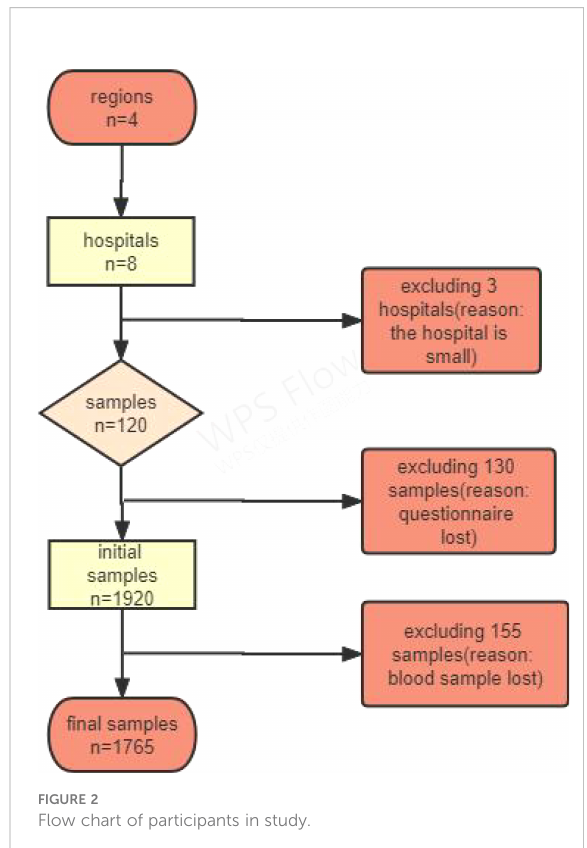
FIGURE 2 Flow chart of participants in